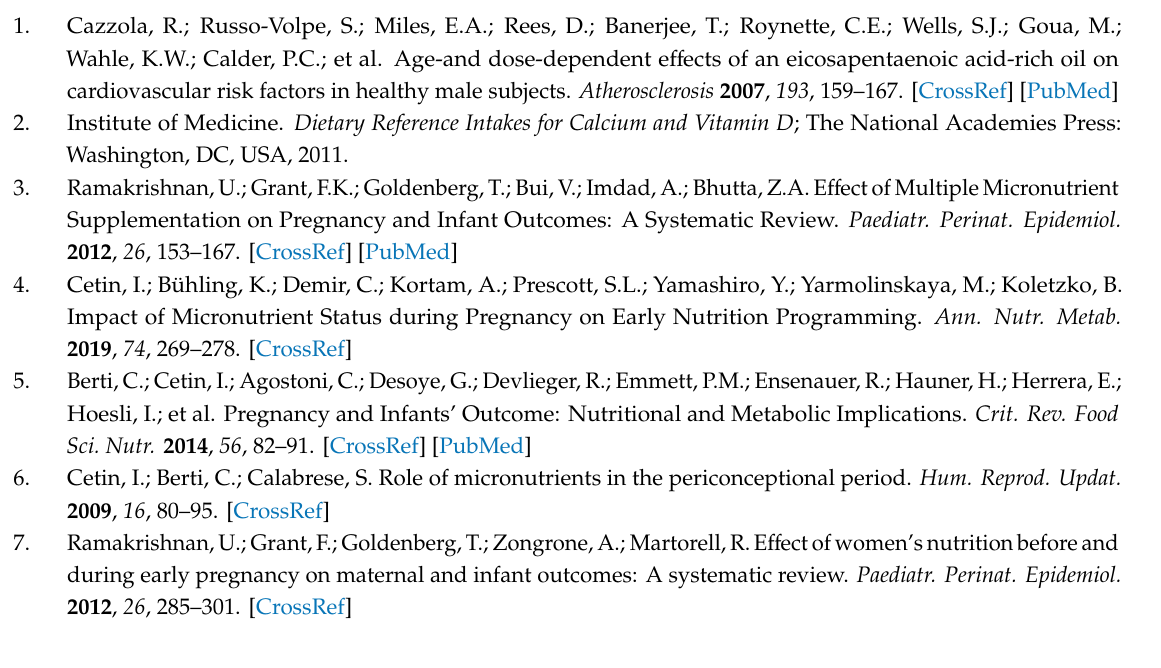
Table S1: Assessment schedule, Table S2: Full list of inclusion and exclusion criteria, Table S3: Composition of the multimicronutrient supplement (MMS) compared to the recommended dietary allowance (RDA) and upper tolerable limits (UL) for pregnant women, Table S4: Blood and plasma sampling for e ffi cacy parameters in all pregnant women, Table S5: Change in primary and secondary maternal e ffi cacy endpoints from Visit 1 to Visit 4 (gestational age week 34 / 36), Table S6: Infant assessments, Table S7: Daily macronutrient intakes during the study (per protocol population) compared with recommended allowances for pregnant